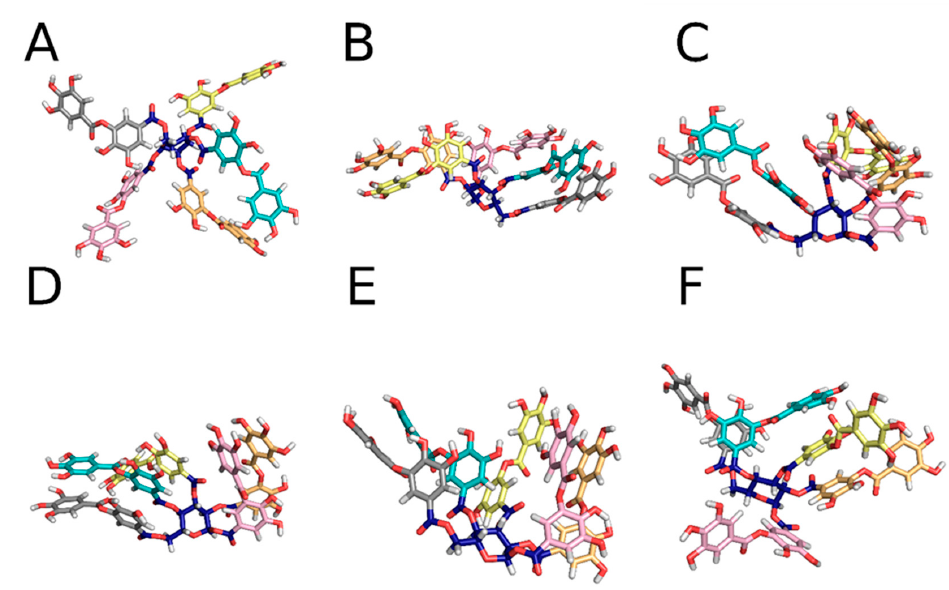
Figure 11. The starting conformation ( A ) and the di ff erent representative structures of tannic acid in the solution ( B – F ). The PGG is in blue, the five di ff erent gallic acid tails are in di ff erent colours. Oxygen atoms are in red, and hydrogen atoms in white.